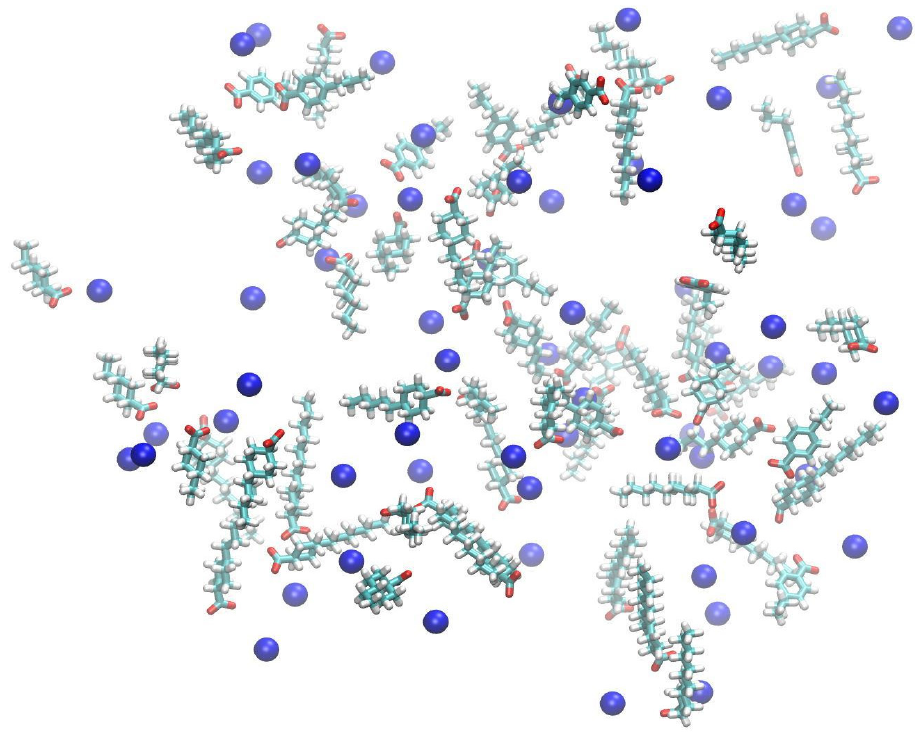
Figure 2. Example of an initial box of the NA mixture simulation with 60 NAs, 10 of each type (water molecules were omitted).